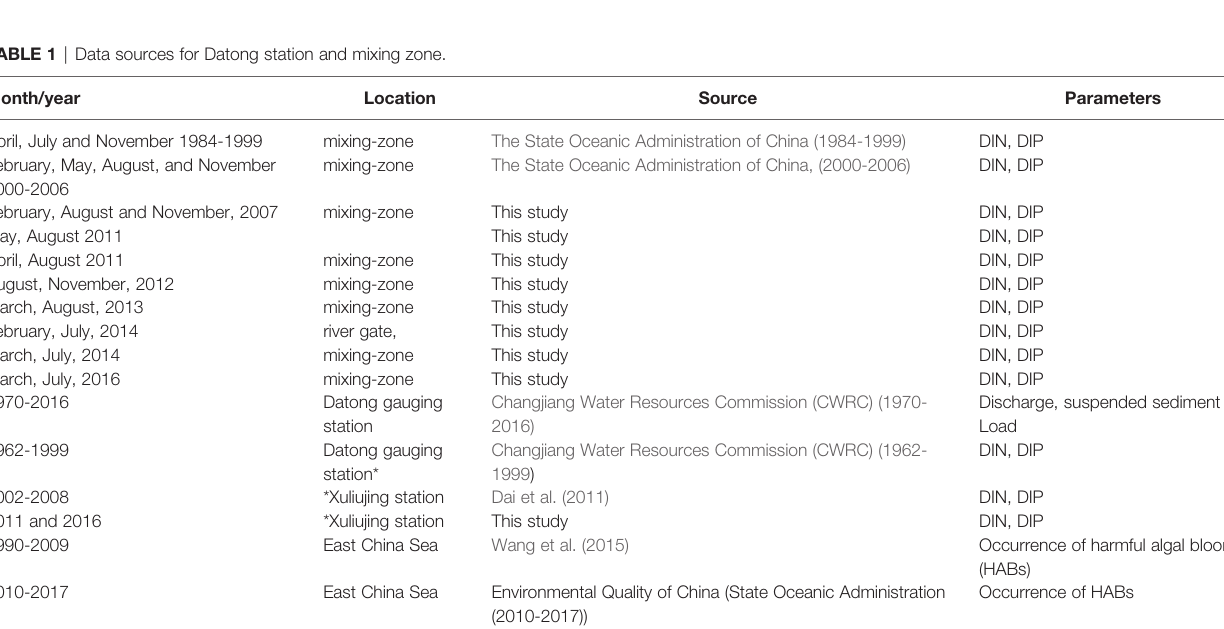
*TheDatongStationislocatedinthemainstreamofthelowerreachesoftheChangjiangRiver.ItistheupperboundaryoftheriverthatcanbeaffectedbytheoceantidesoftheEastChina Sea. Xuliujing station is located 500 km downstream of Datong and is used here in combination with the Datong stations data, which can represent the riverine materials fl owing into the Changjiang River Estuary.